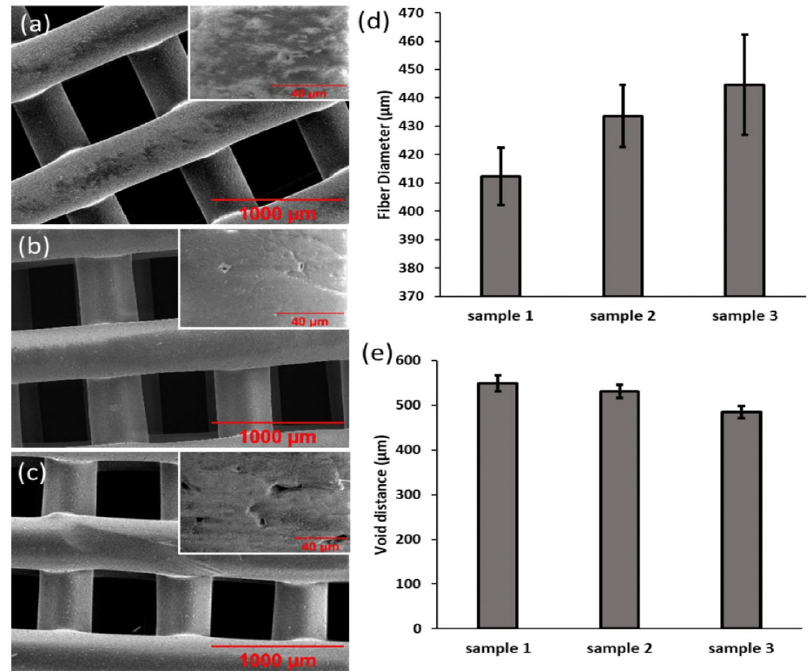
Figure 3. SEM images of 3D-printed ( a ) sample 1, ( b ) sample 2 and ( c ) sample 3 with insets of surface morphology. Distribution of average size of ( d ) fiber diameter and ( e ) void distance.